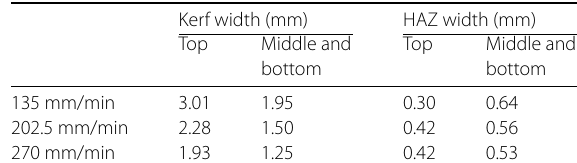
Table 2 Kerf and Heat Affected Zone (HAZ) width after flame cutting on the top, middle and bottom of the plate for different velocities